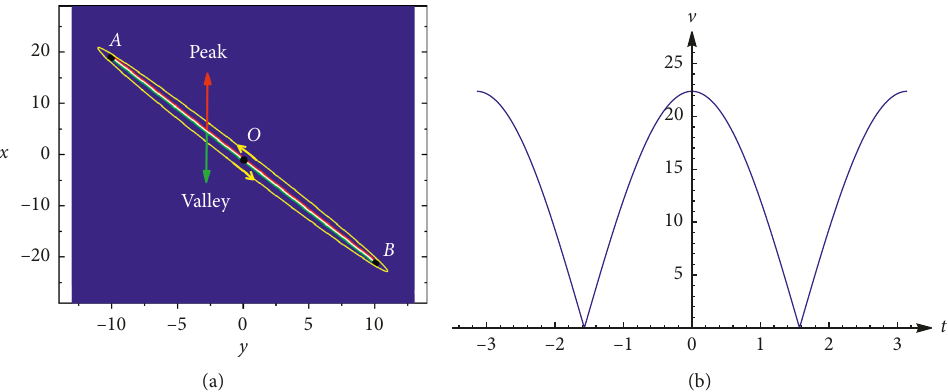
Figure 2: (a) The segment-typed trajectory of the nonautonomous lump wave via the solution (9). (b) The velocity curve of the non- autonomous lump wave with time. The variable coefficients are taken as α same as Figure 1.